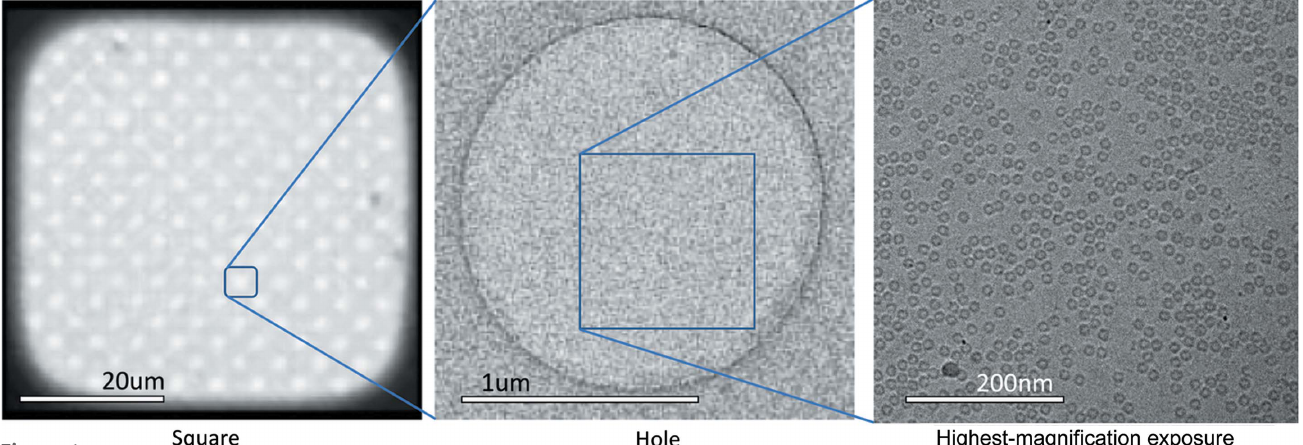
Figure 1 Example square, hole and highest-magnification exposure. Windows in the cryoEM grid containing ice are known as ‘squares’. Within squares are circular ‘holes’. Highest-magnification exposures are taken within holes. Ideal highest-magnification exposures contain particles (as shown) and have thin